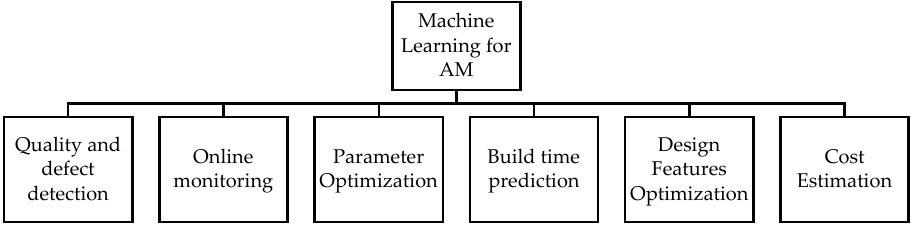
Figure 2. Application of ML in additive manufacturing.